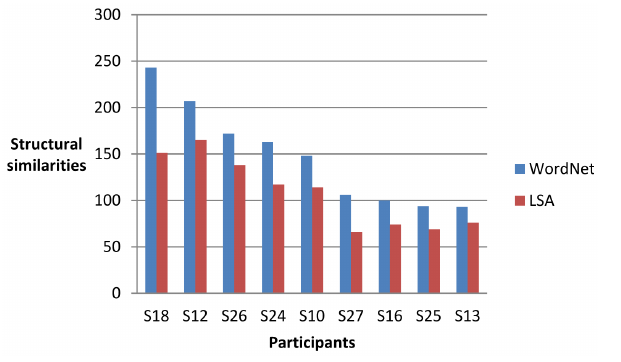
Figure 18. Significant structural similarities (partial orders of similarity differences invariant between the brain data and the linguistic data) for the set of words { Berlin,Rome,Warsaw,north, south, east, west, France, Greece, Poland } from 60 single-trial classifications for each participant.